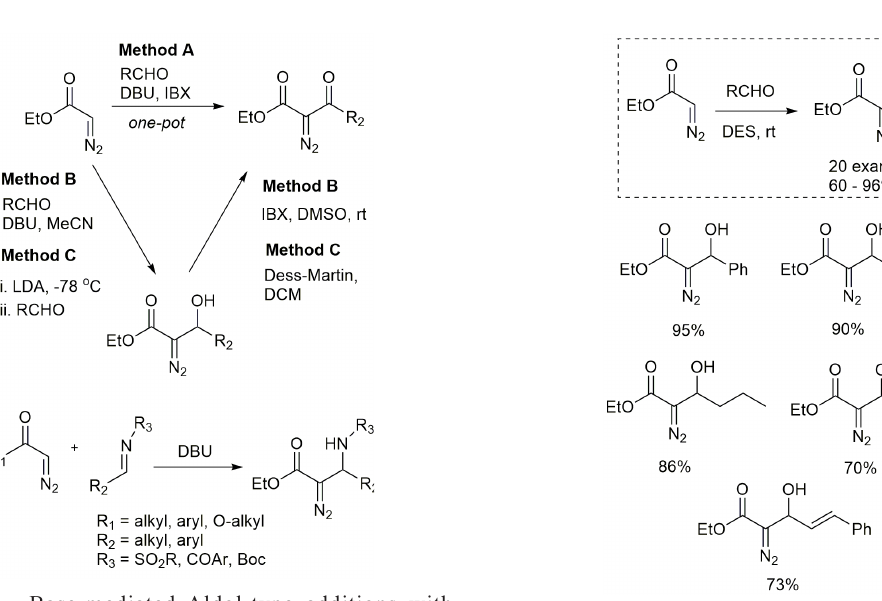
Figure 49 - Aldol-type coupling of α-diazocarbonyl compounds using deep eutectic solvent (DES) as dual solvent/ catalyst.